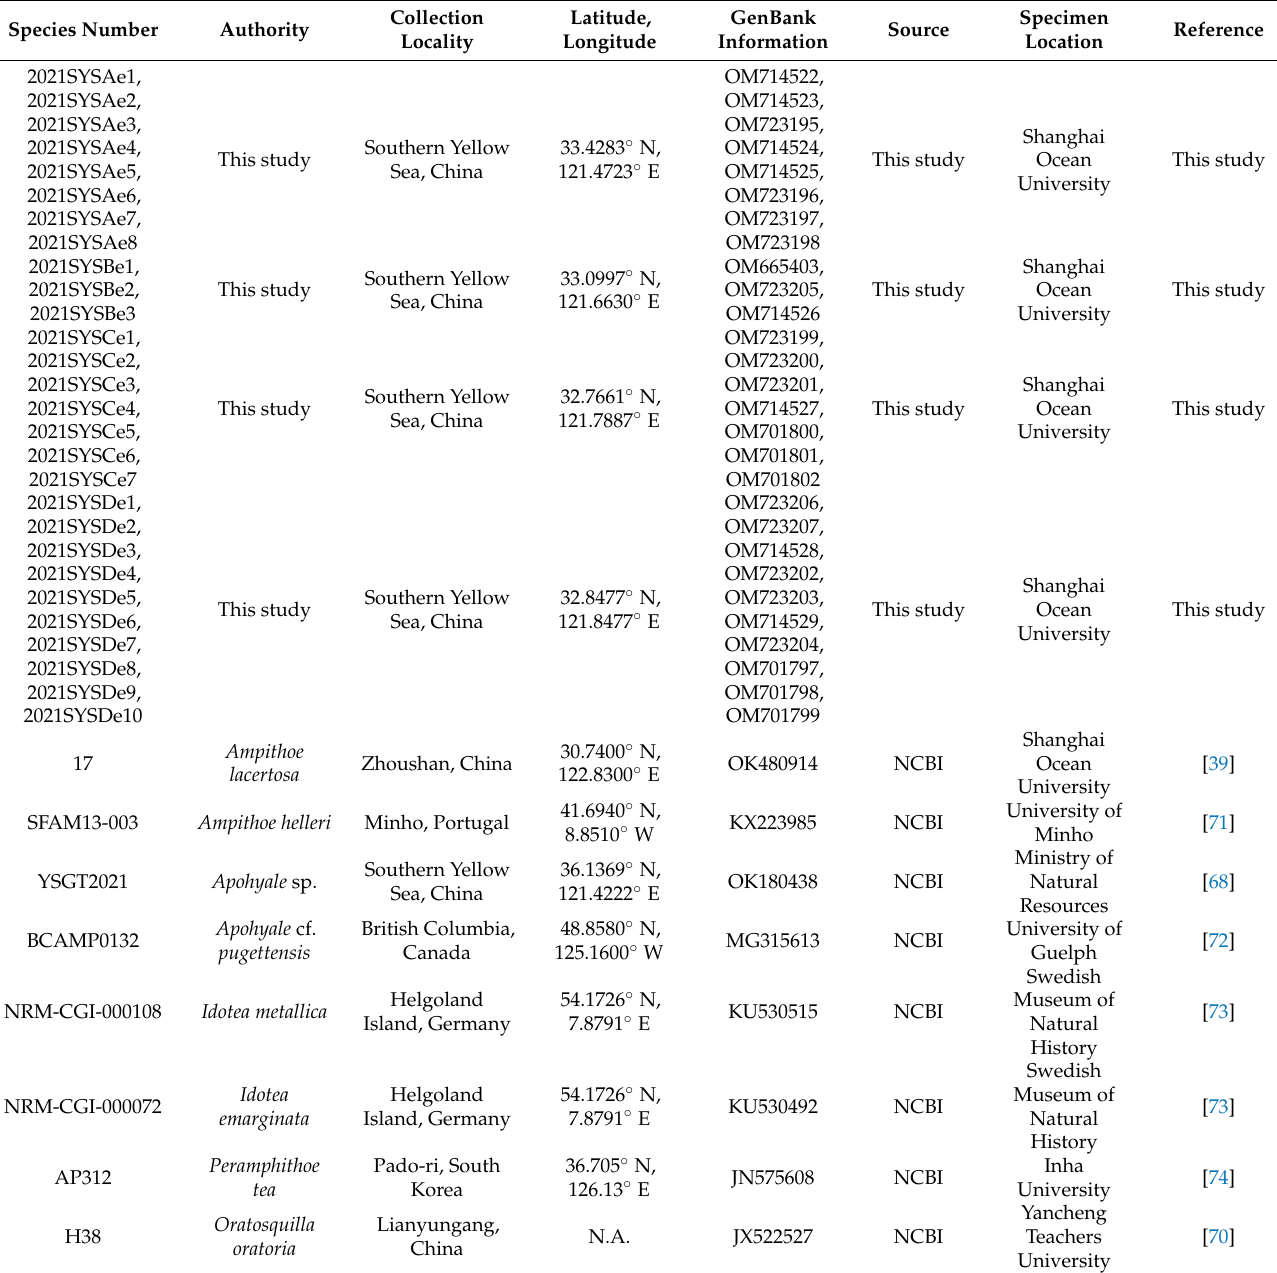
Table 2. Detailed information about the epizoans used to build the phylogenetic